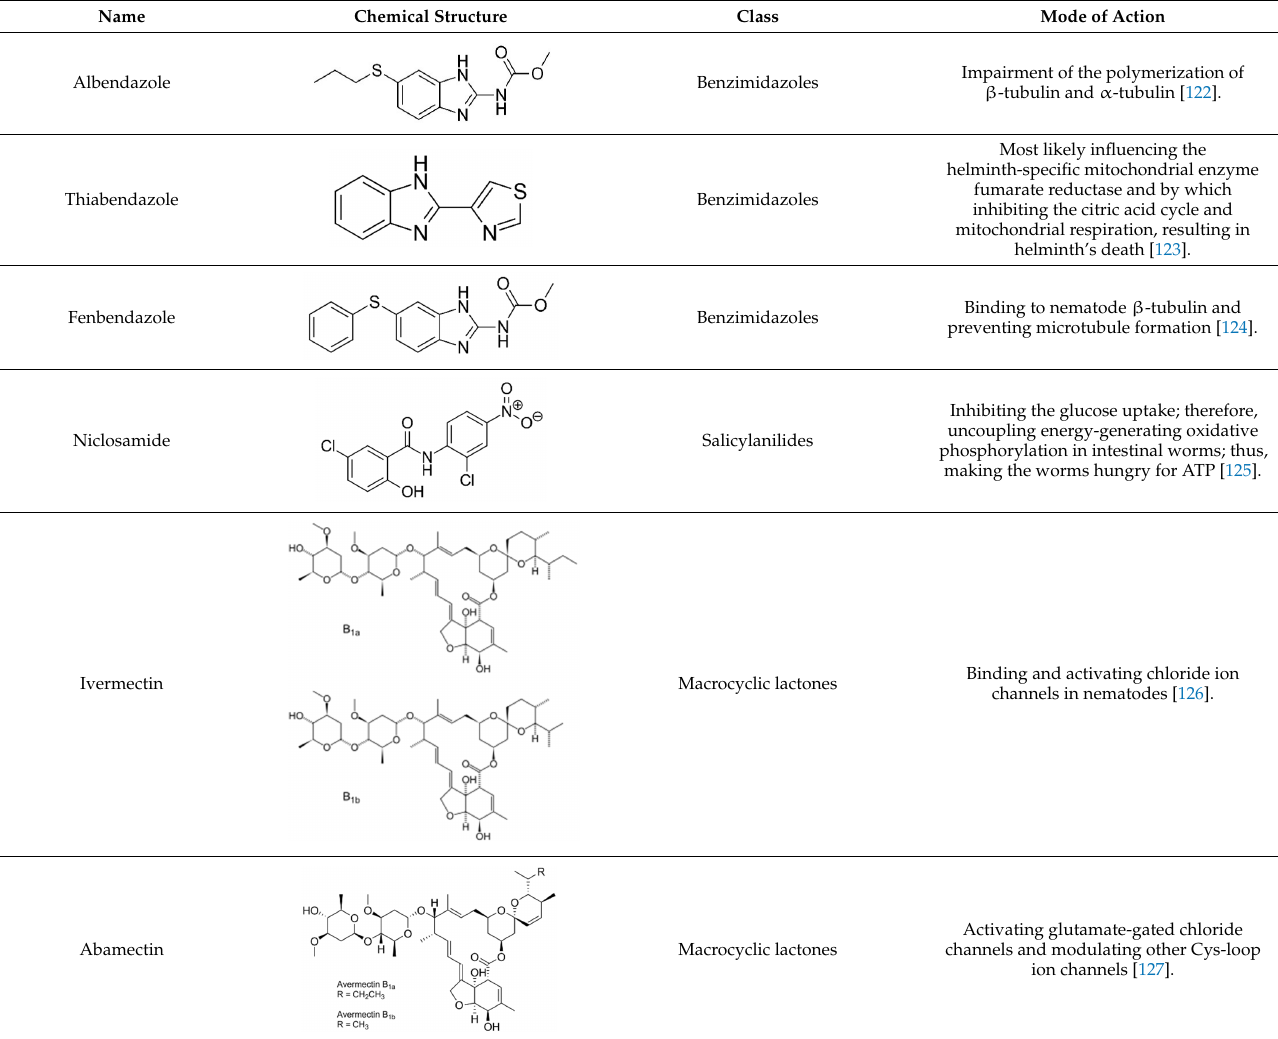
Table 1. Name, chemical structure, class, and mode of action of various anthelmintics.